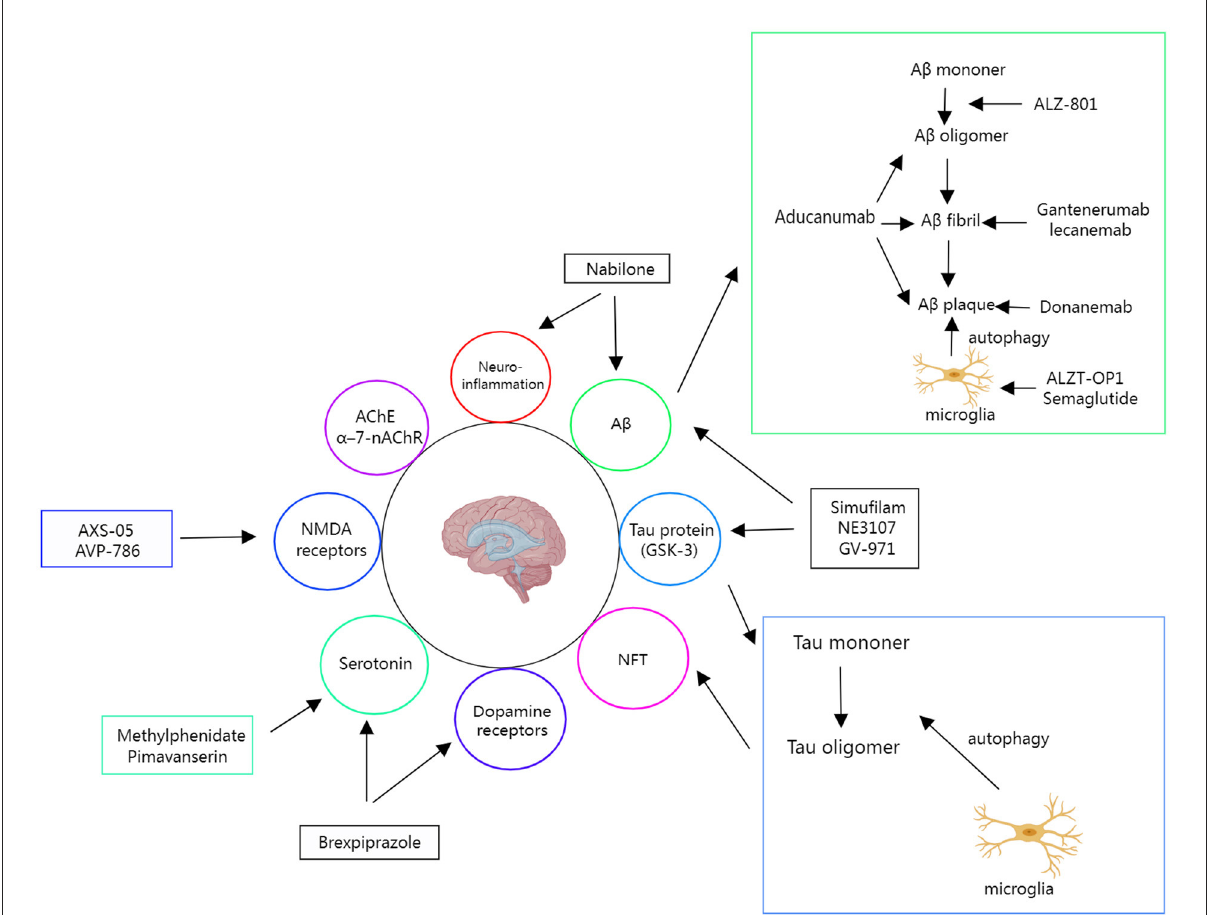
FIGURE1 Various therapeutic targets in AD and candidates entering late-stage